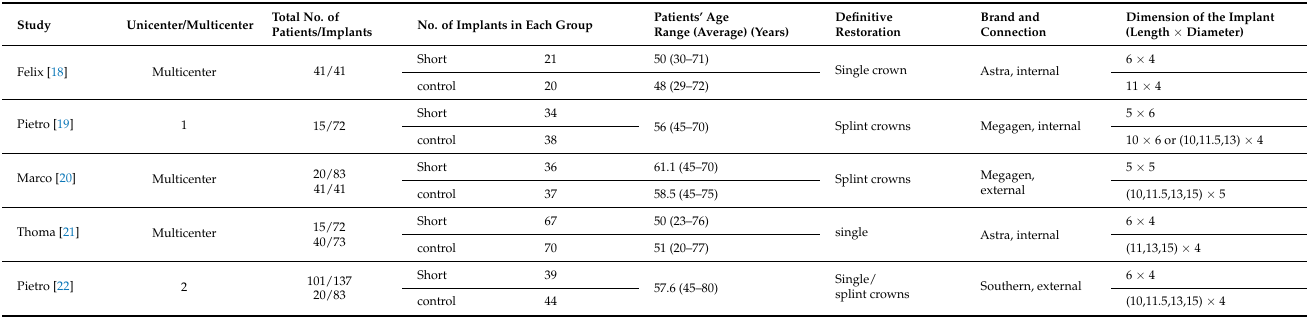
Table 2. Characteristics of the included studies.